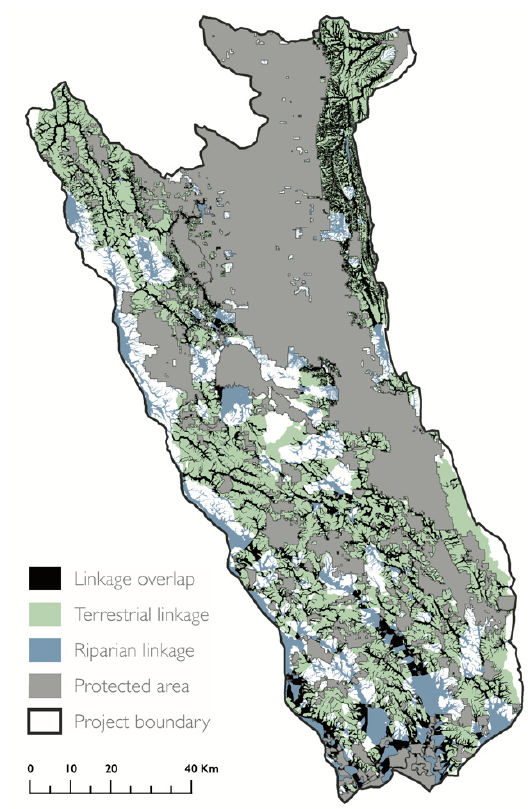
Figure 3. Areas that possess both terrestrial and riparian connectivity value. Map of the Mayacamas to Berryessa project area and protected areas (gray) overlaid with the silhouettes of terrestrial (green) and riparian (blue) linkages. Locations where terrestrial and riparian linkages overlap are shown in black.